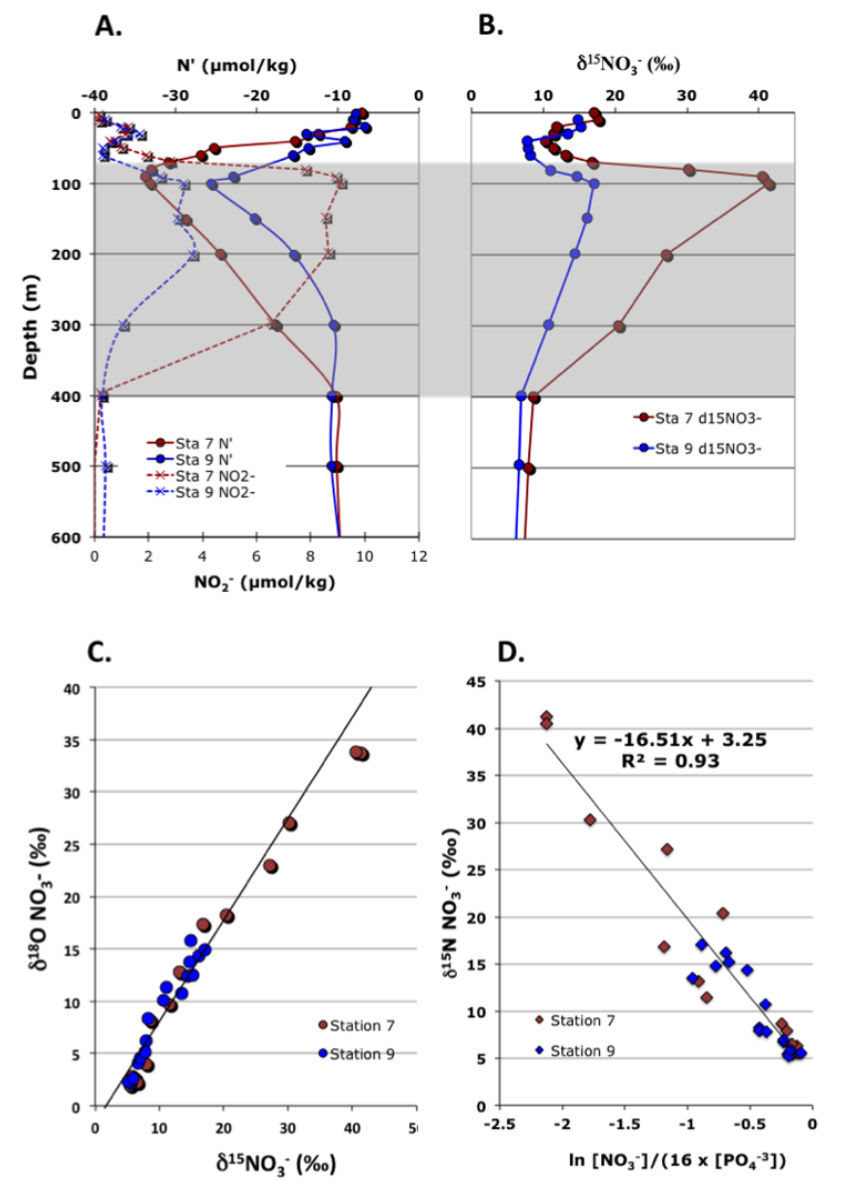
Fig. 2. Depth profiles for N-loss indicators at Station 7 showing extreme values as compared to nearby, shoreward Station 9. OMZ (O 2 < 3µmolkg − 1 ) indicated as a shaded depth interval (see also Fig. 3). (A) NO − and N-deficit (N 0 ) concentration profiles (µmolkg − 1 ). 2 (B) Profiles for δ 15 NO − (‰ relative to atmospher N 2 ). (C) Crossplot of the δ 18 O vs. the δ 15 N of NO − . (D) Rayleigh plot of δ 15 NO − vs. 3 3 3 the ln of the residual NO − fraction assuming the NO − concentration prior to removal is approximated as 16 × [PO − 3 ]. The inverse slope 3 3 4 estimates the fractionation effect ( ε ) at ∼